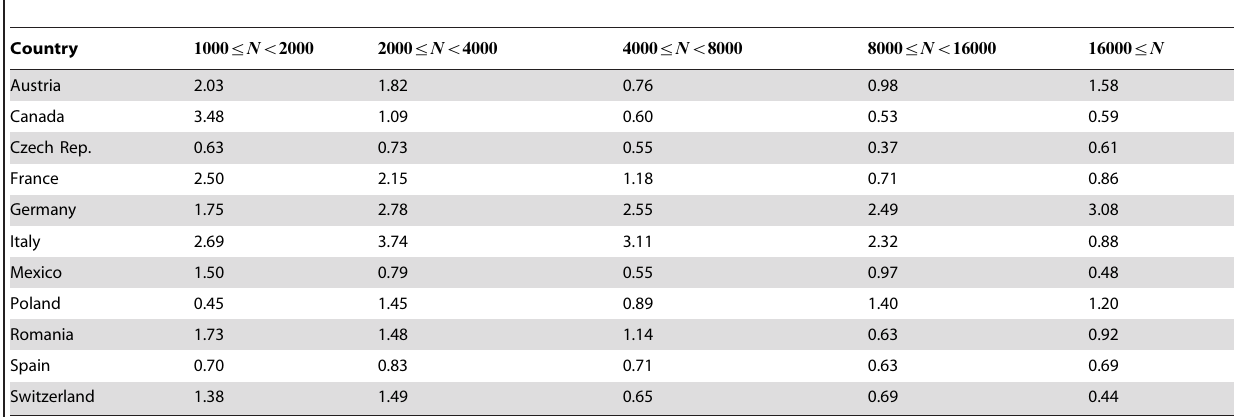
Table 4. KS distance between Q N ( v ) and a normalized Gaussian for different ranges of N and for different countries.